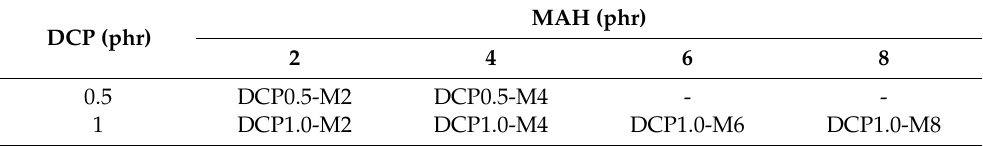
Table 4. Formulations of PLA-g-MAH samples.